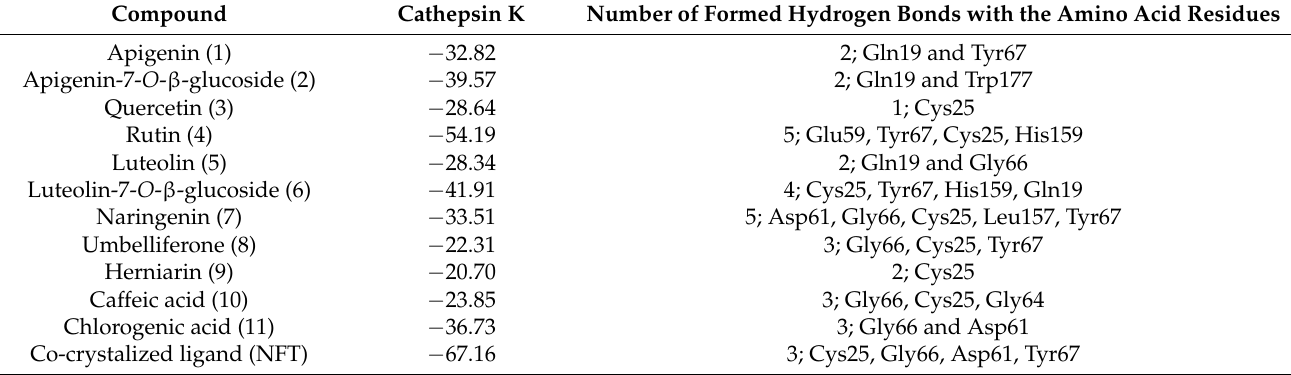
Table 2. Free binding energies (kcal/mol) of the major polyphenolic compounds of Matricaria chamomilla flowers in the active site of cathepsin K using in silico studies. Compound Cathepsin K Number of Formed Hydrogen Bonds with the Amino Acid Residues − 32.82 2; Gln19 and